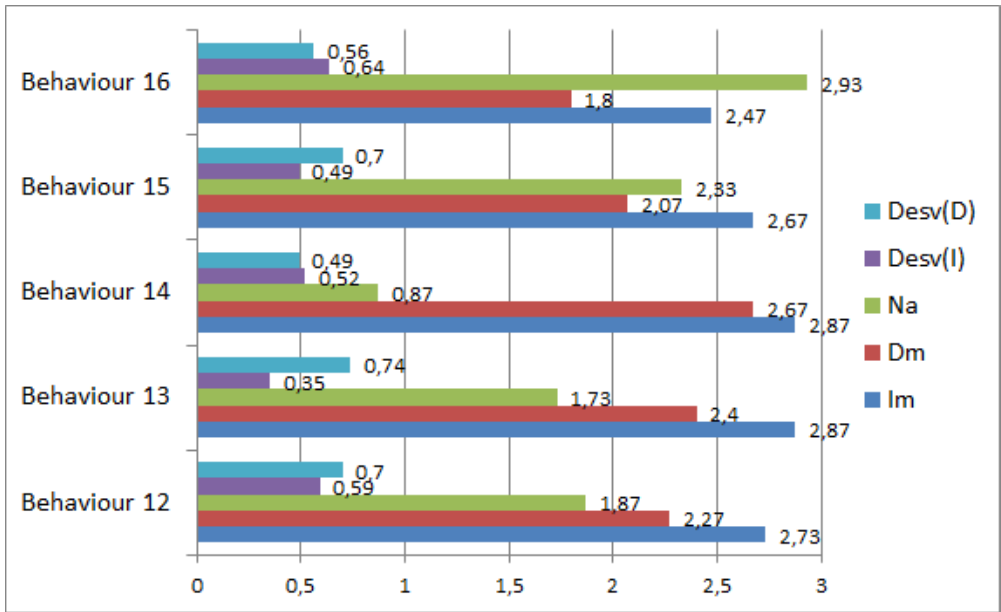
Figure 3. Conversational commitments and re-commitments.